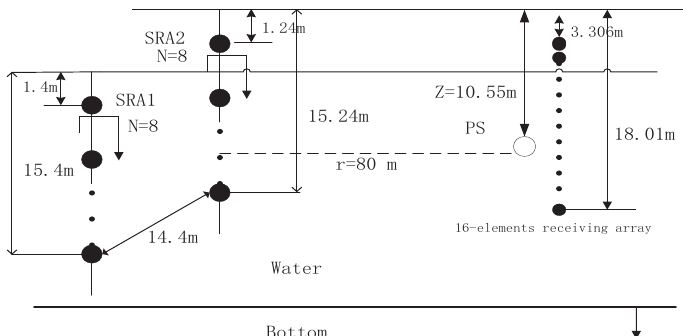
Figure 8. The at-lake experimental configuration for time-reversal focusing. SRA1: time-reversal array1; SRA2: time-reversal array2. SRA1 covers water depth from 1.4 m to 15.4 m. SRA2 covers water depth from 1.24 m to 15.24 m. Distance between SRA1 and SRA2 is 14.4 m. PS: probing source. PS is 80 m far from the center of SRA1 and SRA2; 16-element receiving array covers water depth from 3.306 m to 18.01 m.